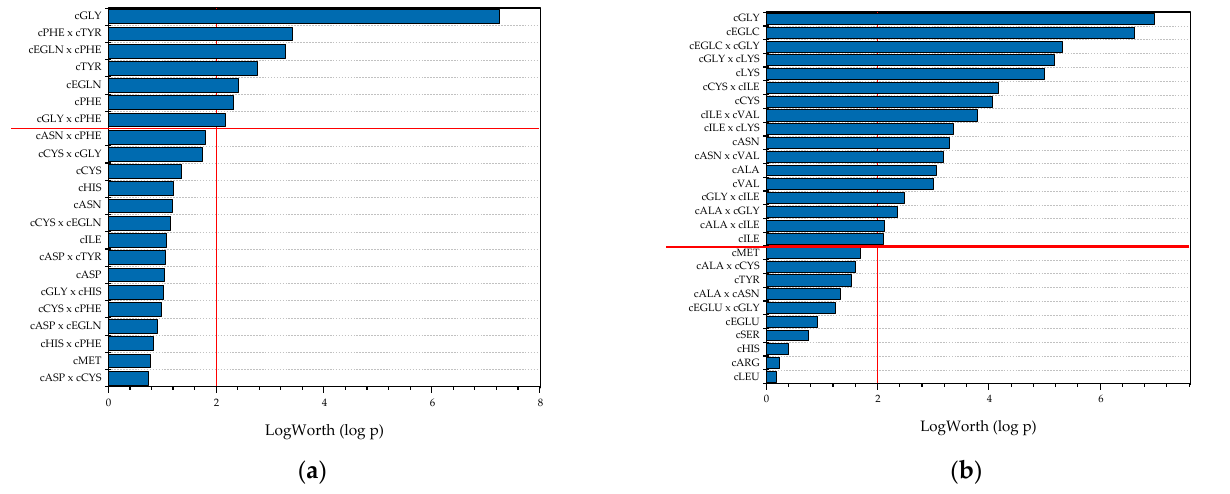
Figure 7. Effect summaries of DoE simulations for ( a ) mAb, and ( b ) viable cell concentration. Although for cell growth GLC and GLY show an equivalent significance, the dominant influence of GLY concentration for product formation can be seen from the small effect of TYR concentration at low GLY concentrations (see Figure 8). All media components show a positive effect direction in the investigated range. With the obtained knowledge about the effect of the media components on cell growth and product formation, an optimized media composition can be